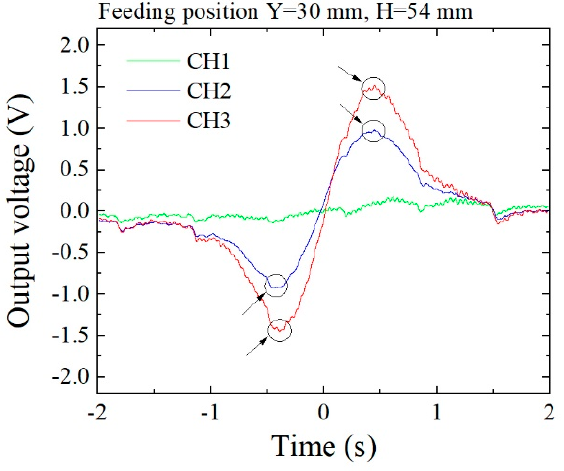
Figure 22. Measured waveforms (feeding point: y = 30, z = 54). Table 1. Results of position estimation (second experiment). Estimated Position (Y,